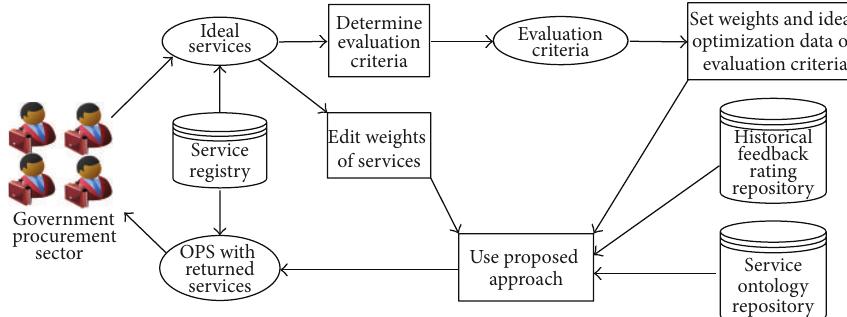
Figure 2: The process of eGP scheme optimization using our proposed